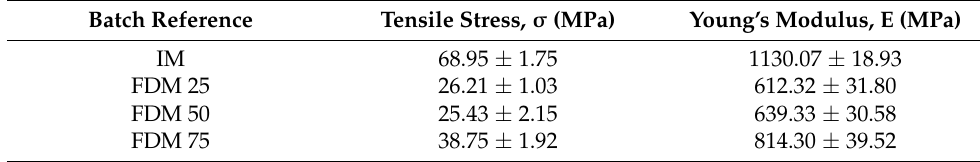
Table 3. Average tensile test results (tensile stress and Young’s Modulus) and their standard deviations for IM and FDM batches.